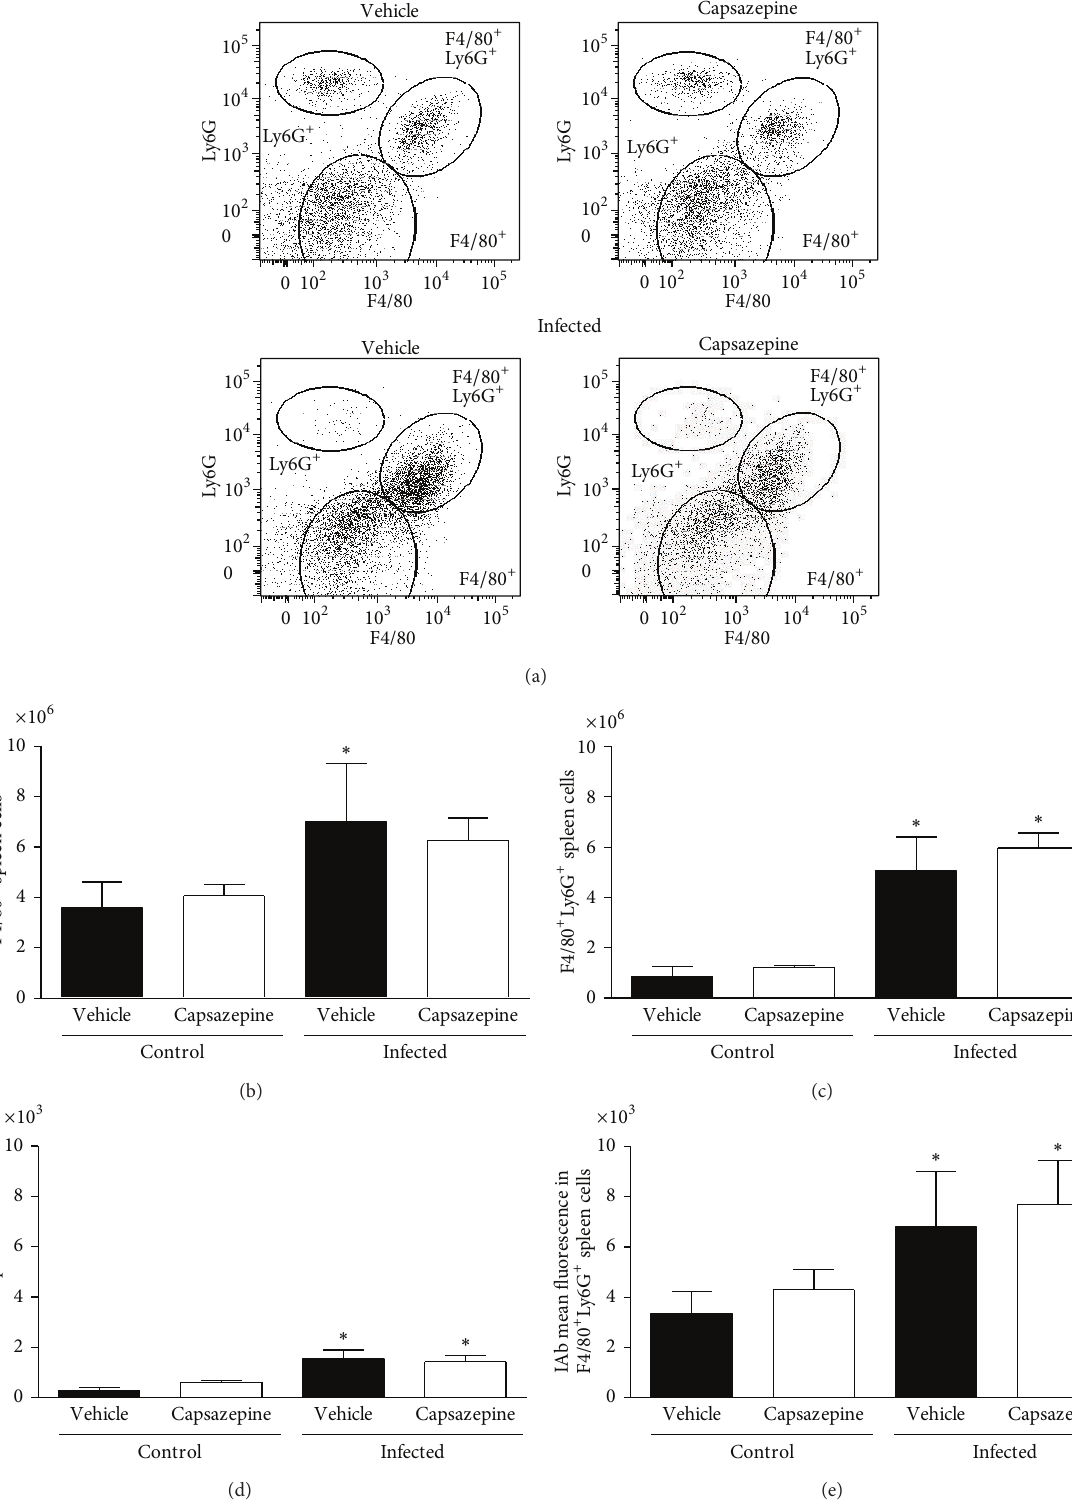
Figure 3: Effect of capsazepine on spleen F4/80 + , F4/80 + Ly6G + , and Ly6G + cells. (a) Representative two-colour dot-plots for spleen F4/80 + , F4/80 + Ly6G + , and Ly6G + cell populations from uninfected and Plasmodium berghei ANKA-infected mice (10 5 infected RBCs/animal; i.p.). Spleen (b) F4/80 + and (c) F4/80 + Ly6G + cell numbers in uninfected and Plasmodium berghei ANKA-infected mice (10 5 infected RBCs/animal; i.p.). Expression of IAb (mean fluorescence) on spleen (d) F4/80 + and (e) F4/80 + Ly6G + cell populations. Capsazepine (50 𝜇 g/animal, 2x